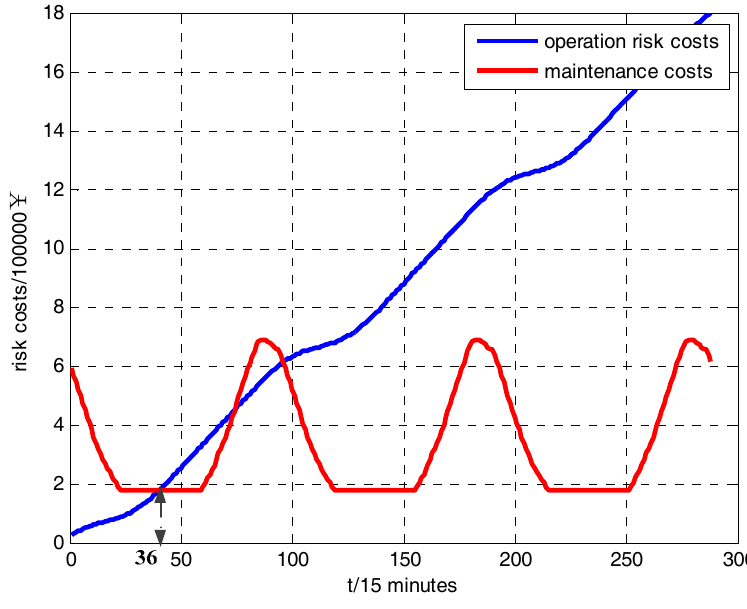
Figure 8. Curves of operation risk costs and maintenance costs.